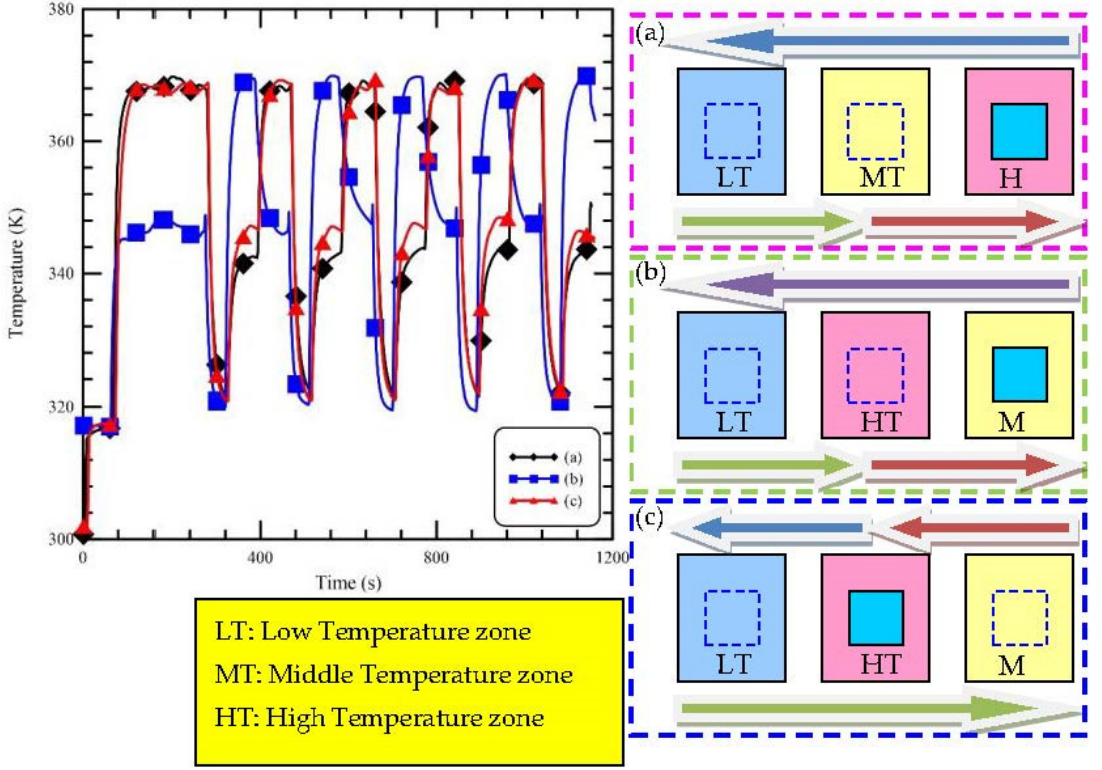
Figure 3. The influence of various arrangement of the heating blocks on the reaction chamber Figure 3. temperatures.